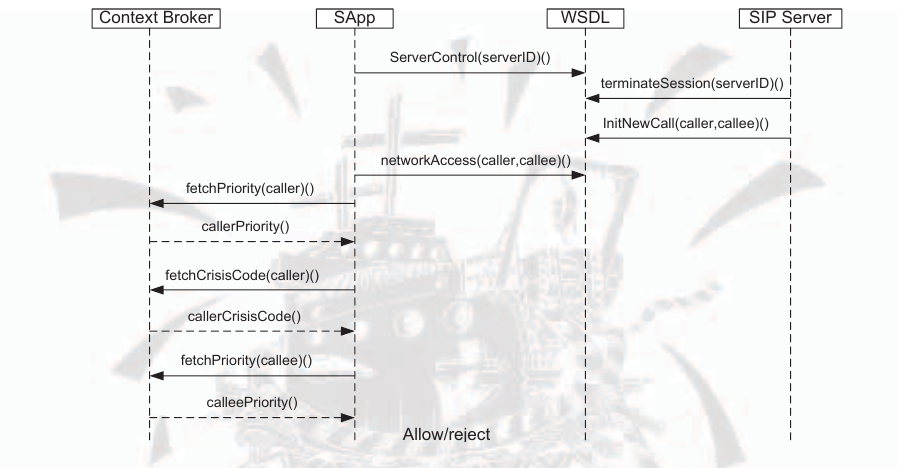
FIGURE 9: VOIP CONGESTION CONTROL SERVICE EXECUTION